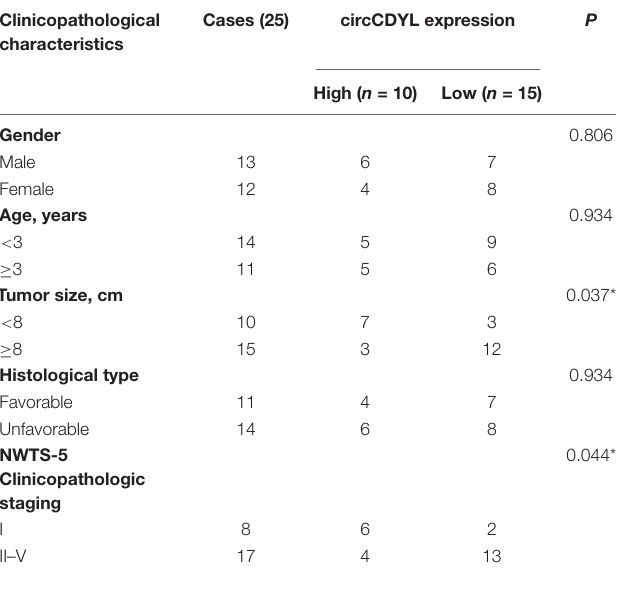
TABLE 1 | Correlation between circCDYL expression and clinicopathological characteristics of WT